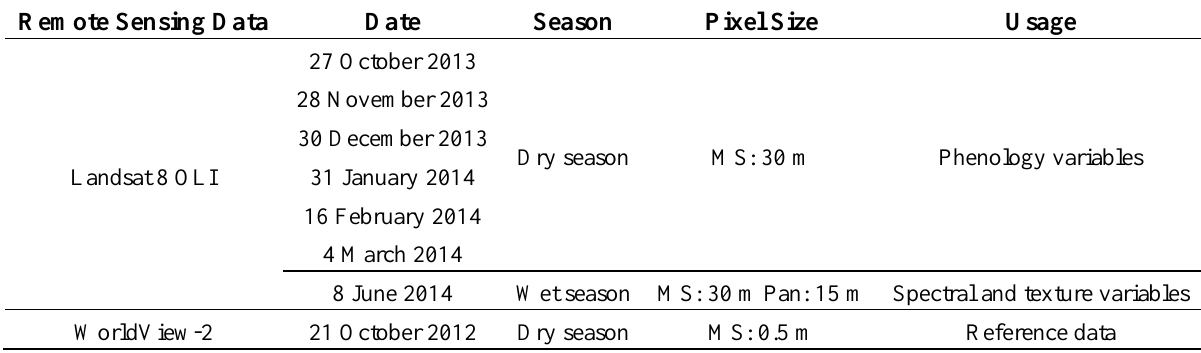
Table 3. Remote sensing data used in this study. MS—multispectral,